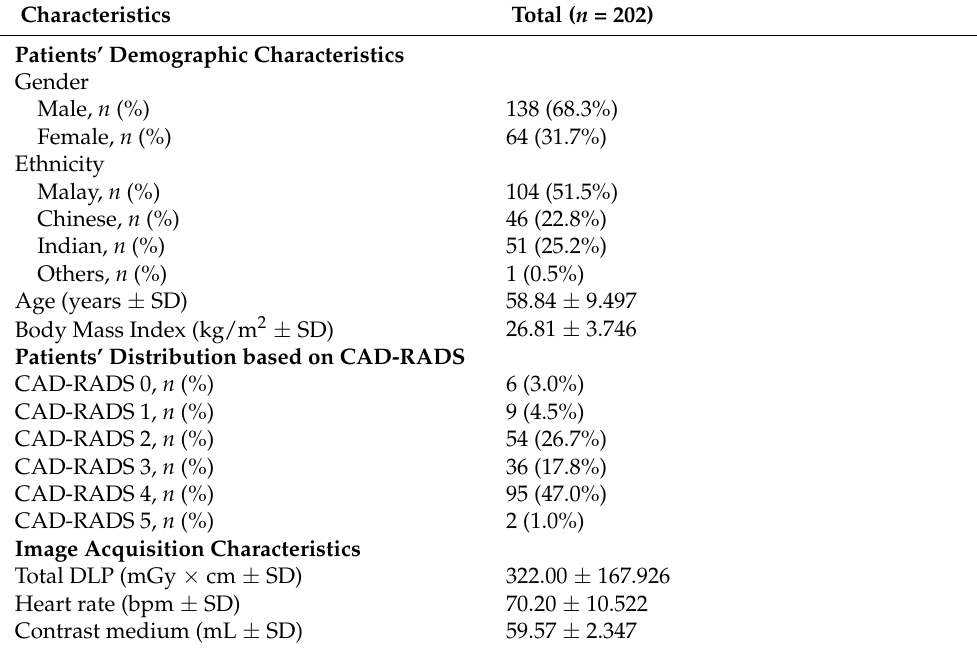
Table 1. Demographic data of the